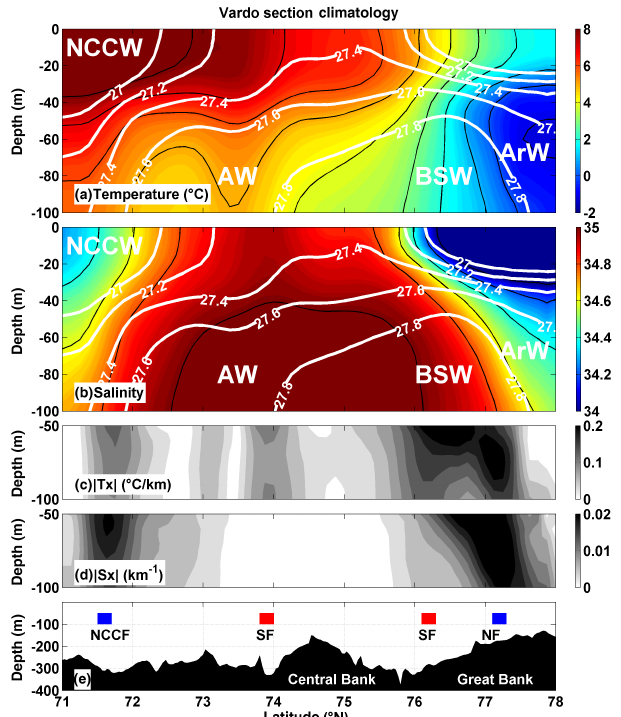
Figure 7. August–September climatology at Vardø section for the 1980–2011 period: temperature ( ◦ C) (a) , salinity (b) . White lines: isopycnals. Black lines: isotherms and isohalines (intervals: 1 ◦ C and 0.1). Norms of horizontal temperature gradient (c) and salin- ity gradient (d) . Bathymetry (e) . The red and blue vertical patches respectively show which front is dominated by the temperature ( D x> 1 ) or salinity ( D x< 1 ) gradients.